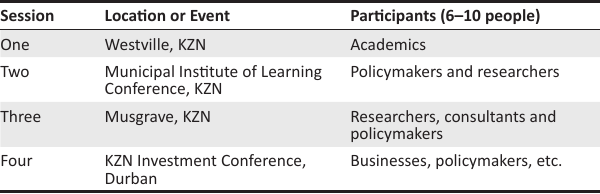
TABLE 1b: Focus group and World Café